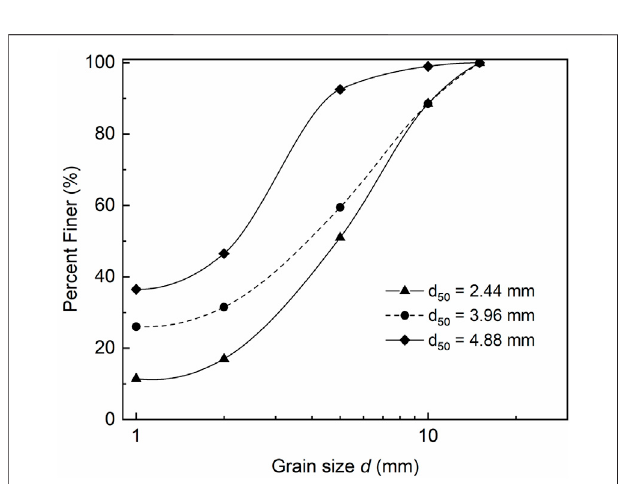
FIGURE 2 | Grain size distributions of three loose sediment mixtures employed for producing arti fi cial dams with varying vertical grading structures in the present